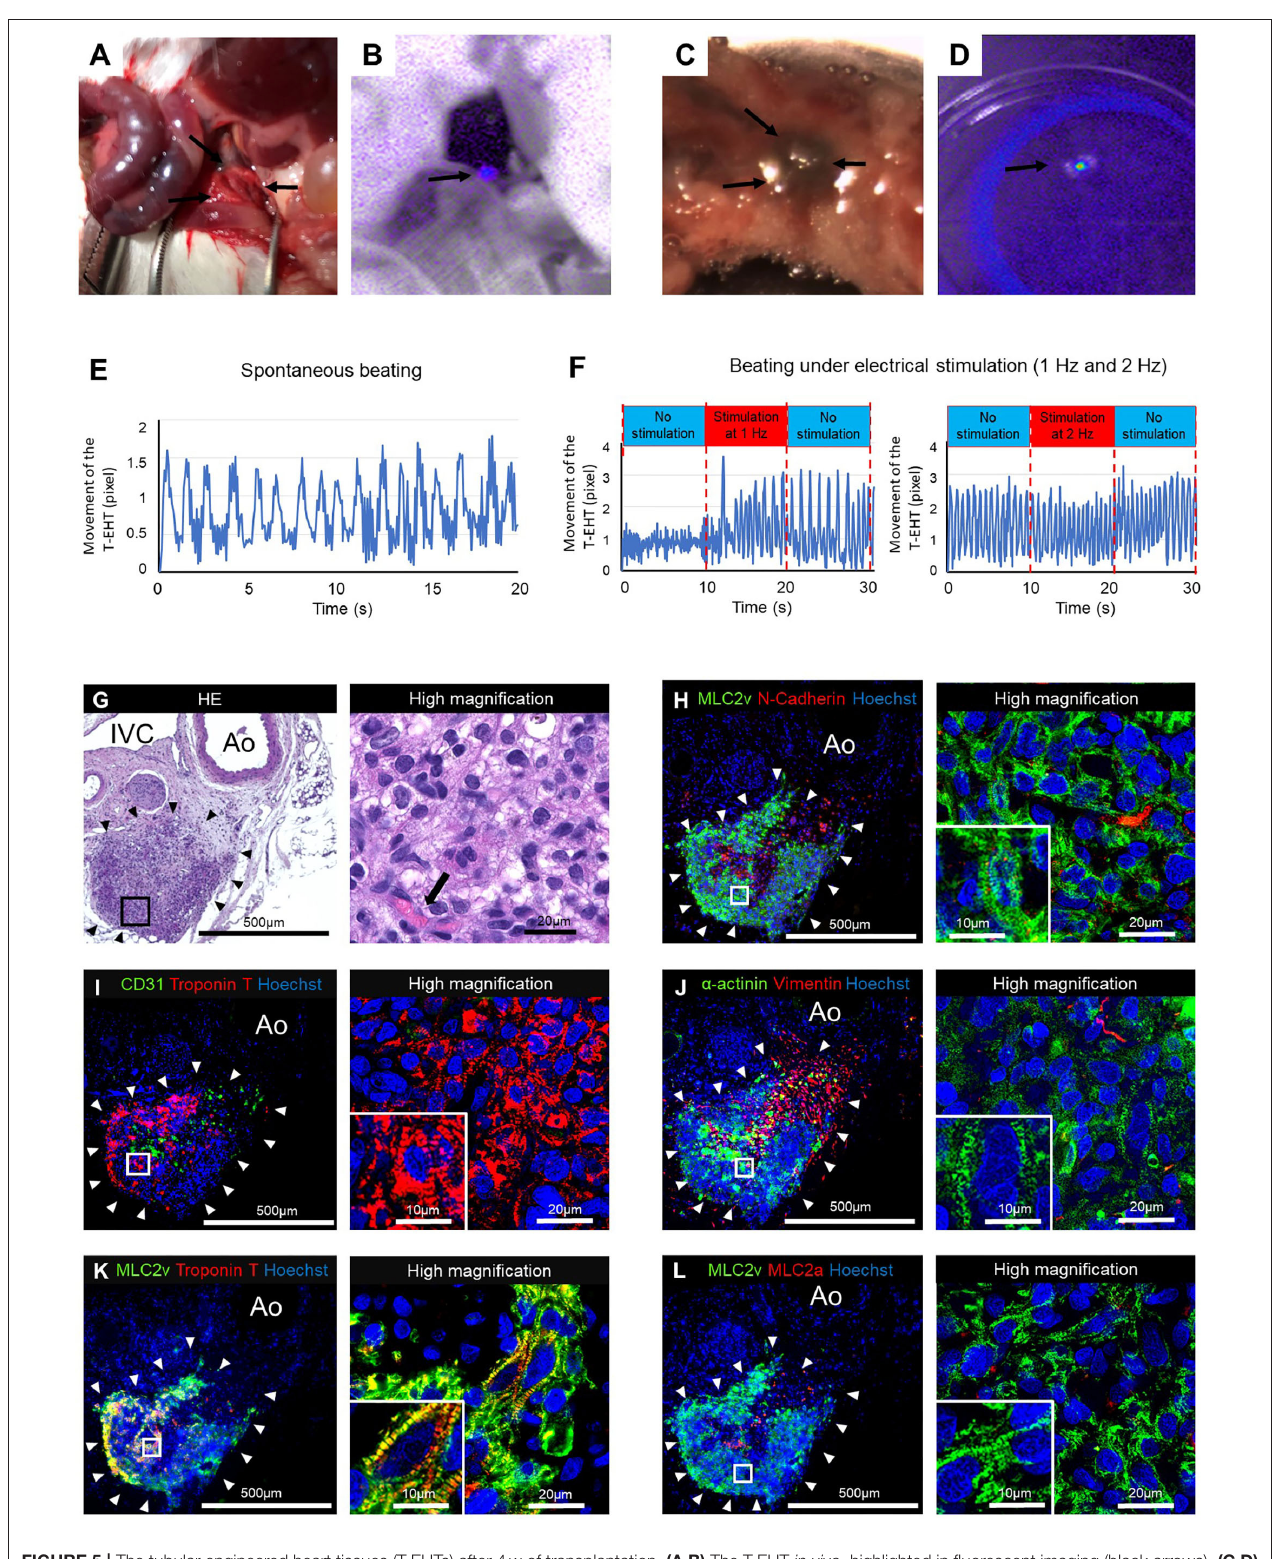
FIGURE 5 | The tubular engineered heart tissues (T-EHTs) after 4w of transplantation. (A,B) The T-EHT in vivo , highlighted in fluorescent imaging (black arrows). (C,D) The T-EHT is being explanted with surrounding tissues, and its fluorescence imaging record (black arrows). (E) Beating analysis of explanted T-EHT. The